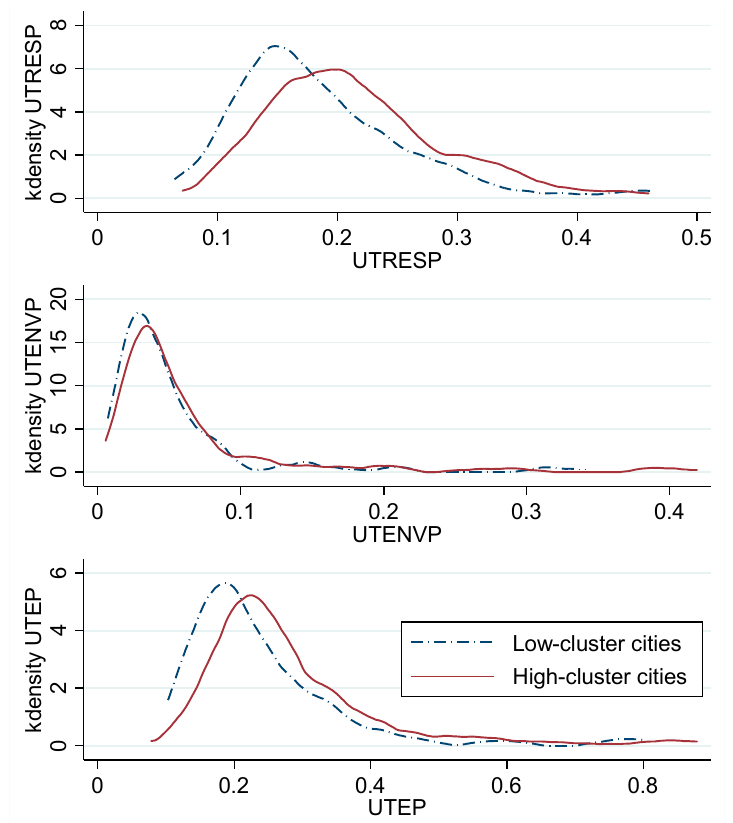
Figure 2. Kernel density curves of UTEP, UTRESP, and UTENVP .